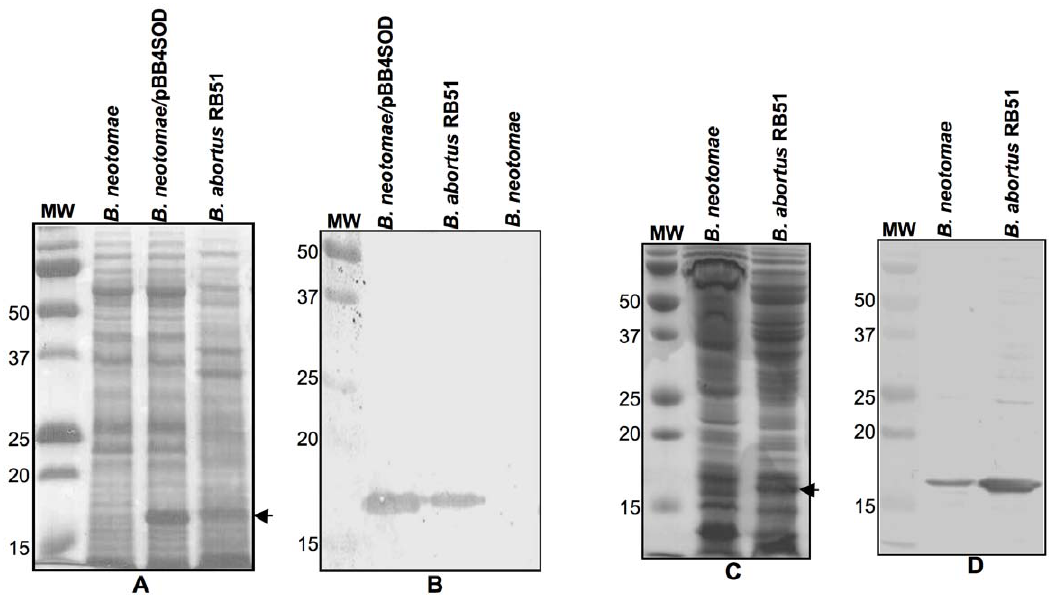
Figure 1. Detection of SOD expression in B.neotomae , B.neotomae /pBB4SOD, and B.abortus RB51 by SDS-PAGE (A and C) and Western blot analysis (B and D). Total antigens of 10 7 (A and B) or 10 9 (C and D) CFU of the indicated bacteria were loaded on each lane. The SDS- PAGE gels were stained with Coomassie brilliant blue G (A and C). For Western blot analysis (B and D), goat anti- Brucella SOD serum was used as the primary antibody for reacting with the antigens. In all panels, lanes marked MW contain molecular weight markers and the numbers at the left indicate approximate molecular masses in kilodaltons. Arrows in panels A and C indicate the SOD protein.